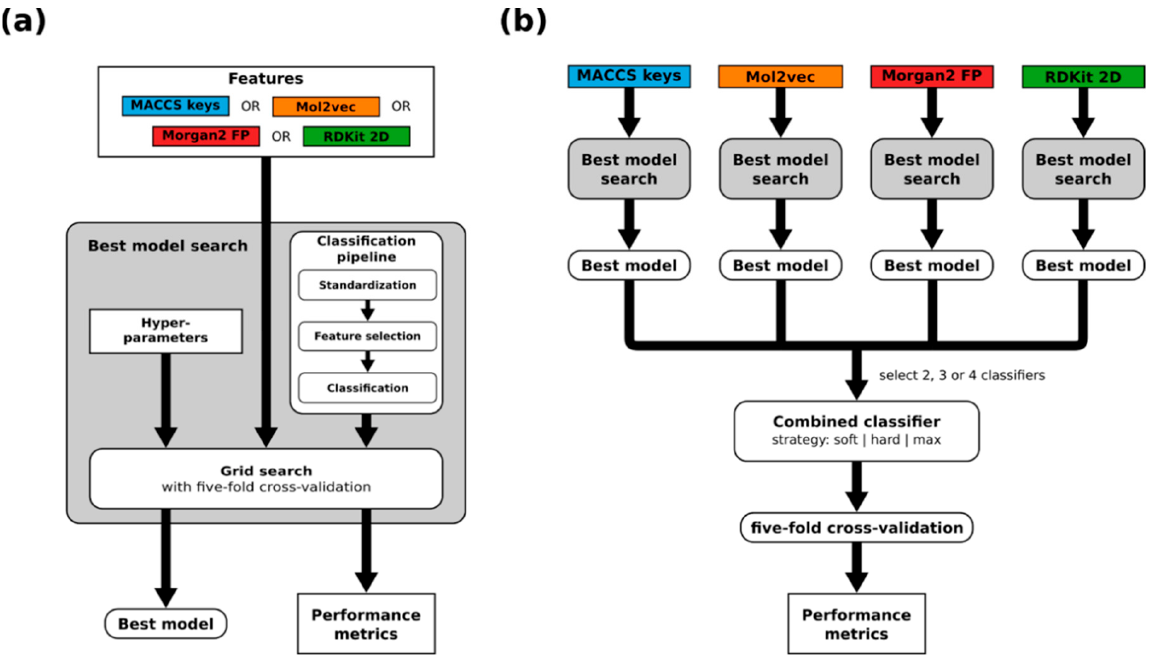
Figure 3. Overview of the modeling workflows utilized in this work. ( a ) Workflow for the generation of single models. ( b ) Workflow for the generation of combined models.